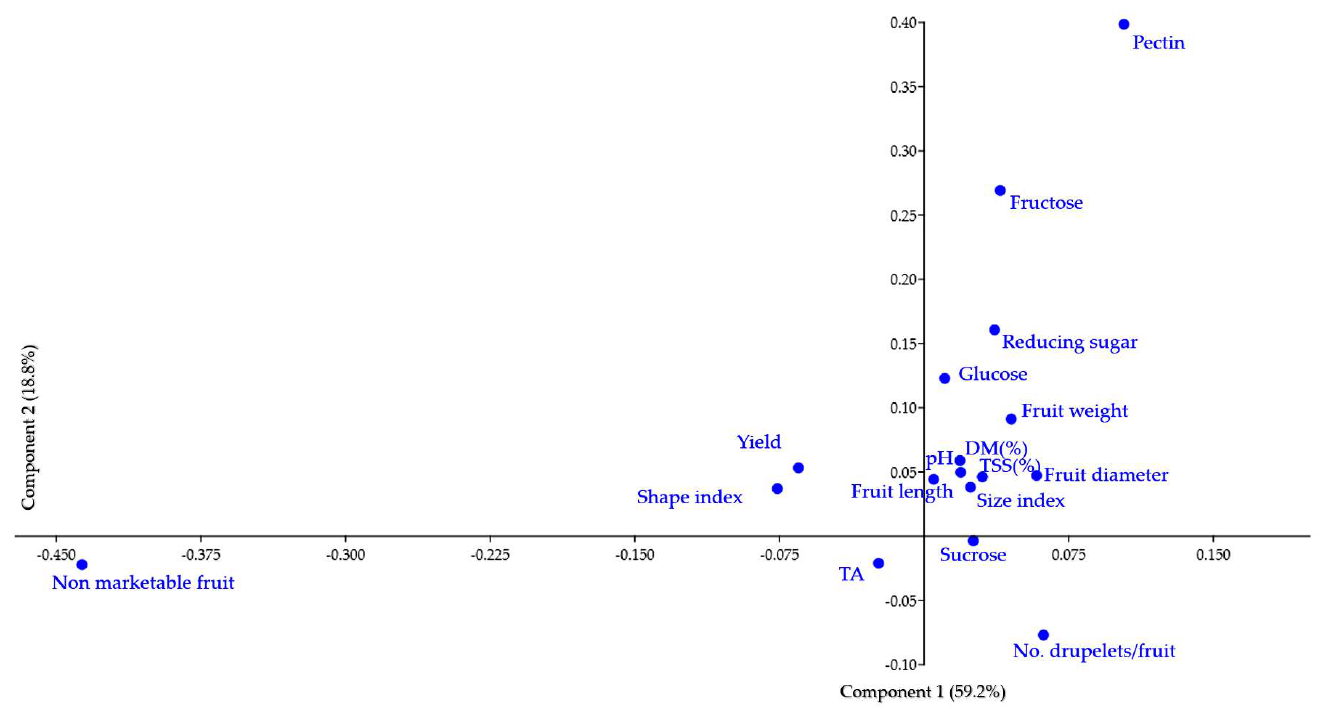
Figure 4. The correspondence analysis (CA) of the 17 characteristics analyzed in the 24 raspberry genotypes (14 promising selections (clones), their parents, and Glen Ample cultivar as control).